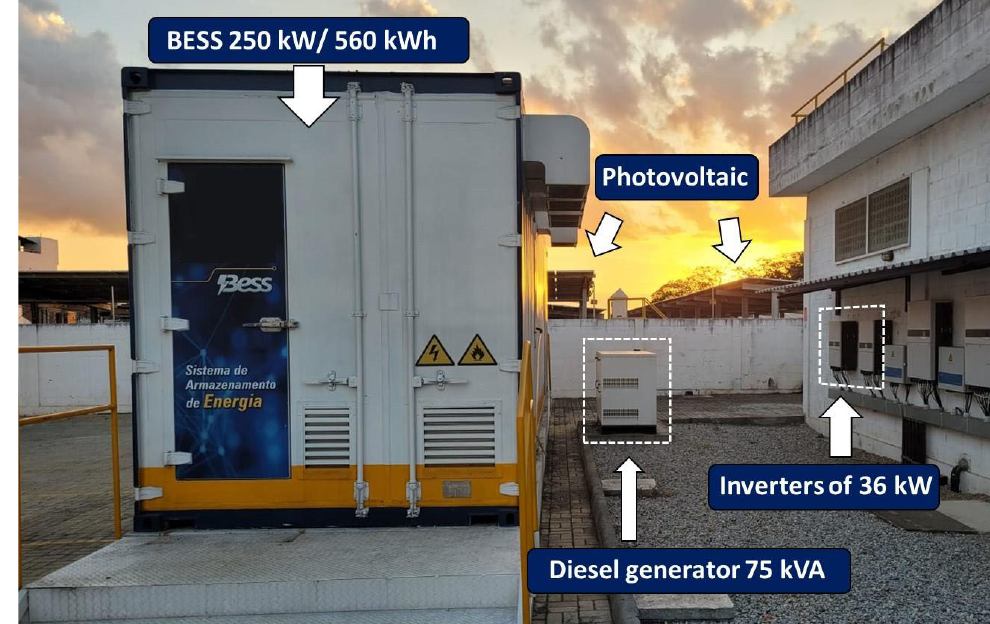
Figure 7. Real view of the main equipment used in the tests.